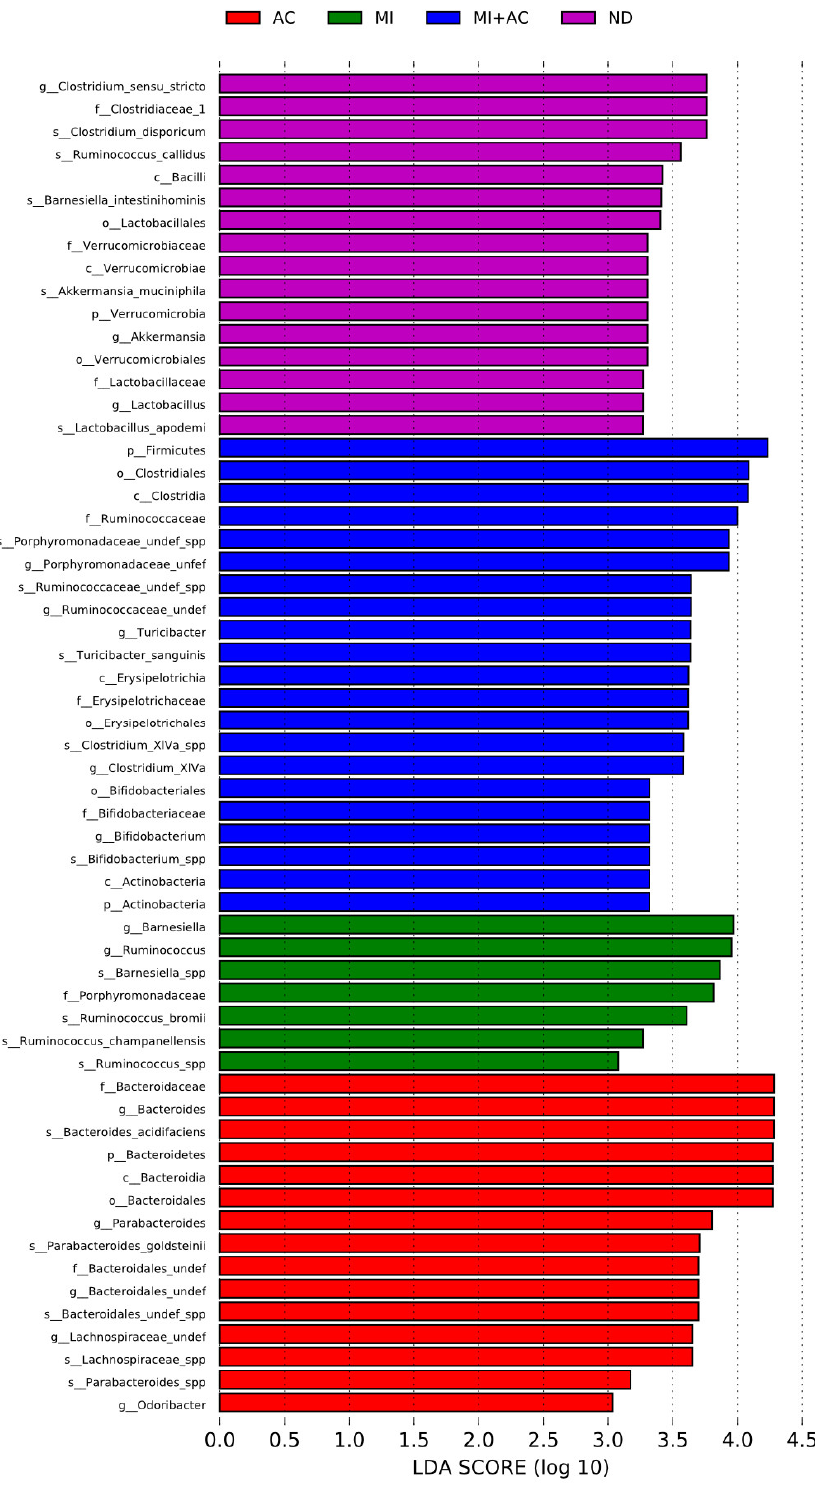
Figure 6. Effect of maternal minocycline administration (MI) and acetate supplementation (AC) on the offspring’s gut microbiome. Most enriched bacterial taxa in the ND (purple), MI (green), AC (red), and NI + AC (blue) groups are identified by the linear discriminant analysis effect size (LEfSe) analysis. The threshold on the linear discriminant (LDA) was set to 3. ND = control rats received vehicle; MI = rats received minocycline; AC = rats received acetate; MI + AC = rats received minocycline and acetate administration.